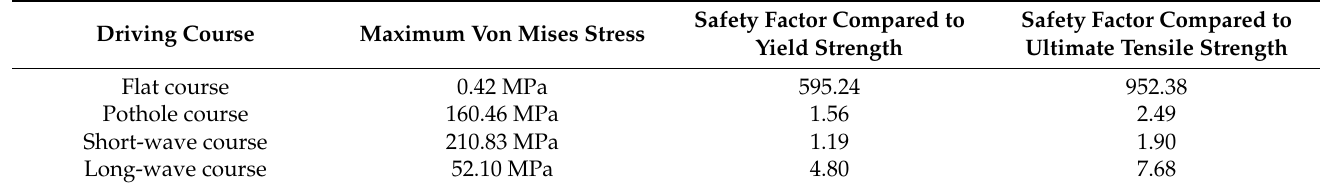
Table 2. Safety factors according to the driving